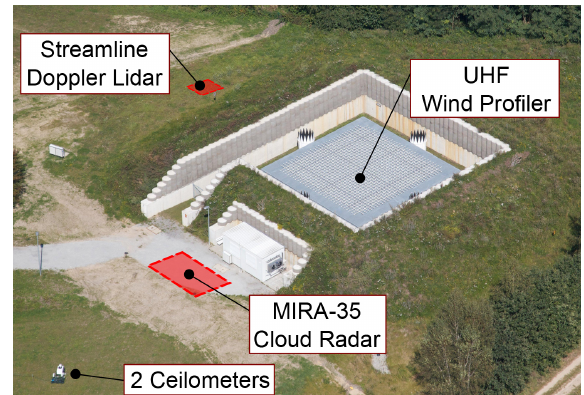
Figure 1. Aerial view of the wind profiler site at MOL. The photo- graph was taken in September 2011. In the meantime a Streamline Doppler lidar and a MIRA-35 cloud radar were deployed next to the wind profiler. During the measurements presented here, all instru- ments were pointing vertical at all times. Operational parameters of the systems measuring vertical velocity can be found in Table 1. (Bühl,